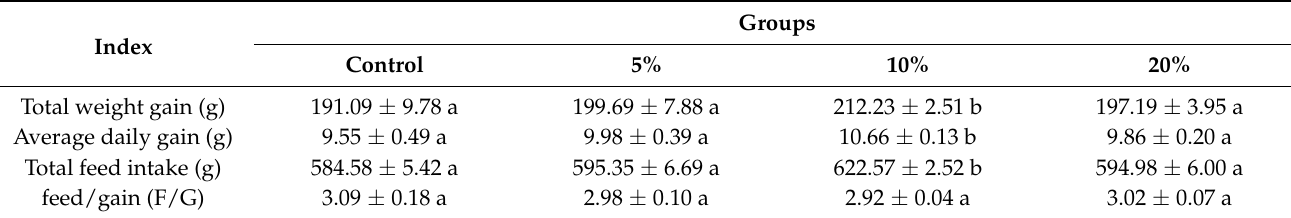
Table 3. The effect of FTWW on the growth performance of chicks.